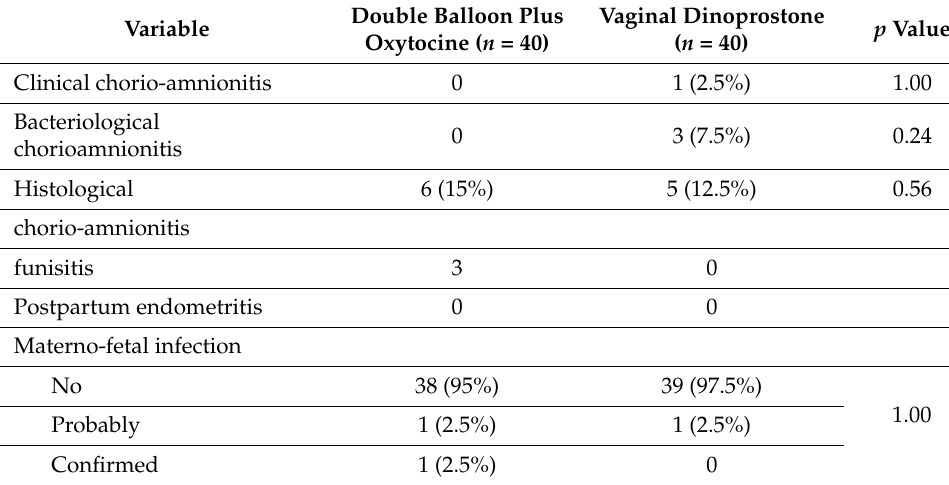
Table 5. Materno-fetal infectious outcomes.